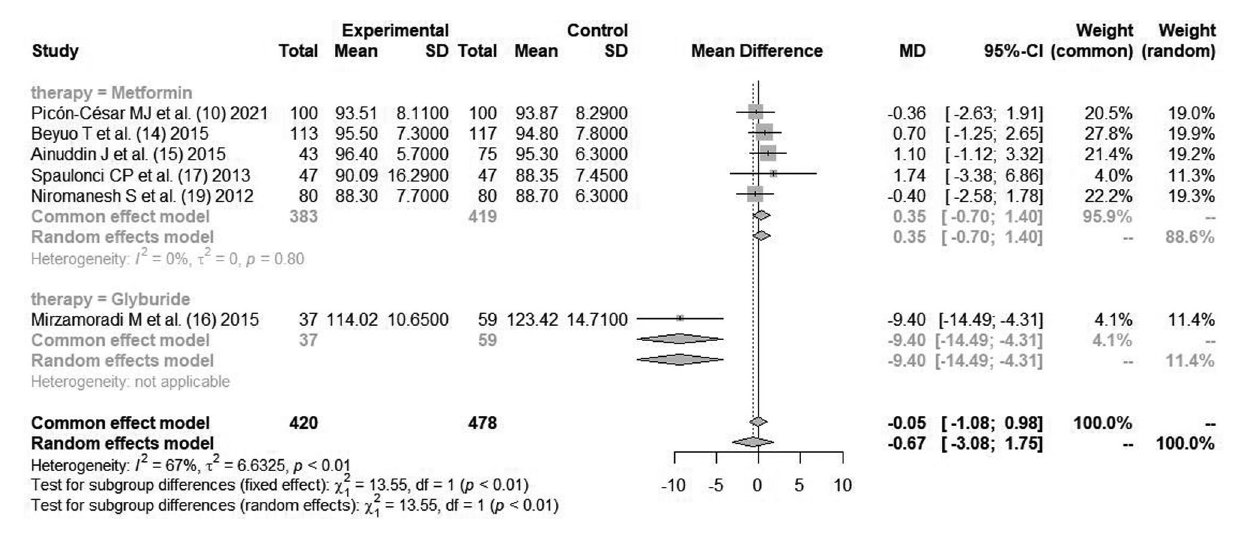
FIGURE 2 | Comparison of fasting glycemia after glycemic control during pregnancy.